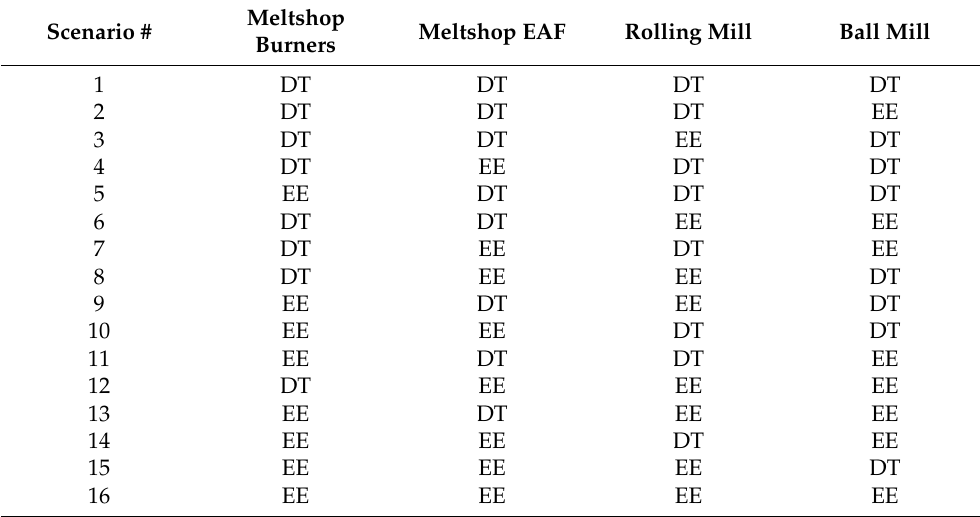
Table 1. Description of different scenarios, combining digital tools and energy efficient solutions as per different parts of the steelmaking